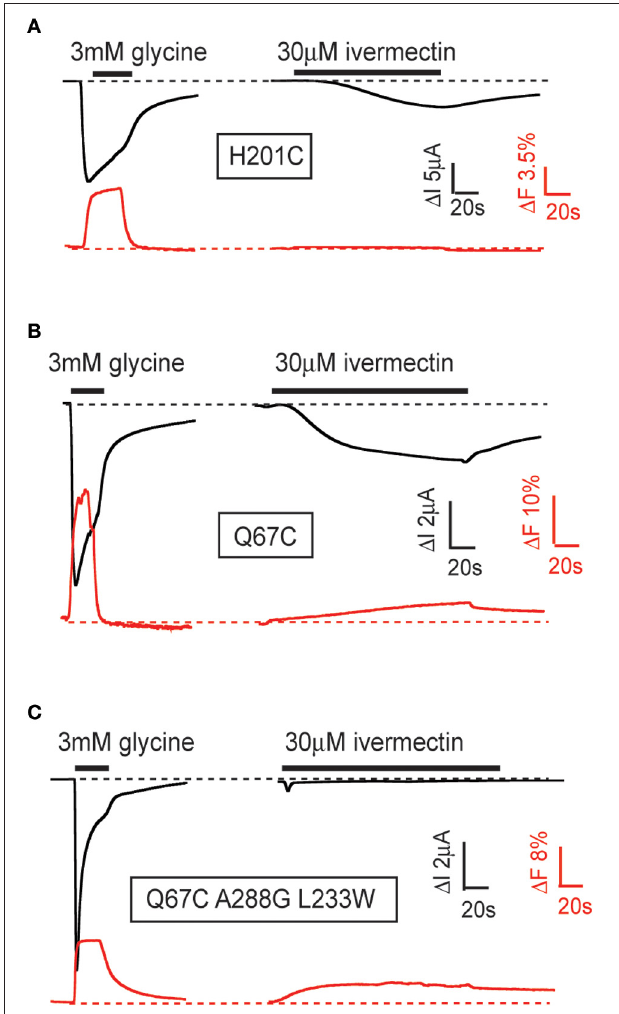
FIGURE 4 | Examples of glycine- and ivermectin-mediated fluorescence and current responses in mutant GlyRs. Current responses (black) and fluorescence responses (red) were recorded simultaneously from Xenopus oocytes expressing indicated α 1 GlyRs. (A) Fluorescence responses induced by glycine, but not ivermectin, in fluorescently labeled H201C mutant GlyRs. (B) Fluorescence responses induced by glycine and ivermectin in fluorescently labeled Q67C mutant GlyRs. (C) Fluorescence responses induced by glycine and ivermectin in fluorescently labeled Q67C, A288G, L233W triple-mutant GlyRs. These mutations convert ivermectin into an antagonist of glycine-gated currents. The figure is modified from Wang and Lynch (2012). Please refer to that paper for full experimental